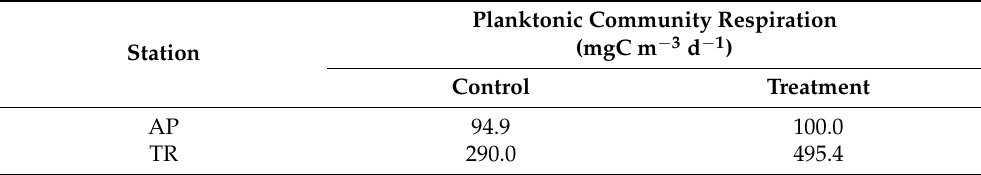
Table 4. Planktonic community respiration of organic carbon. Abbreviations: AP: coastal Avery Point site; TR: estuarine Thames River site. Treatment denotes samples after two days of rolling, and control denotes samples incubated for two days without rolling.